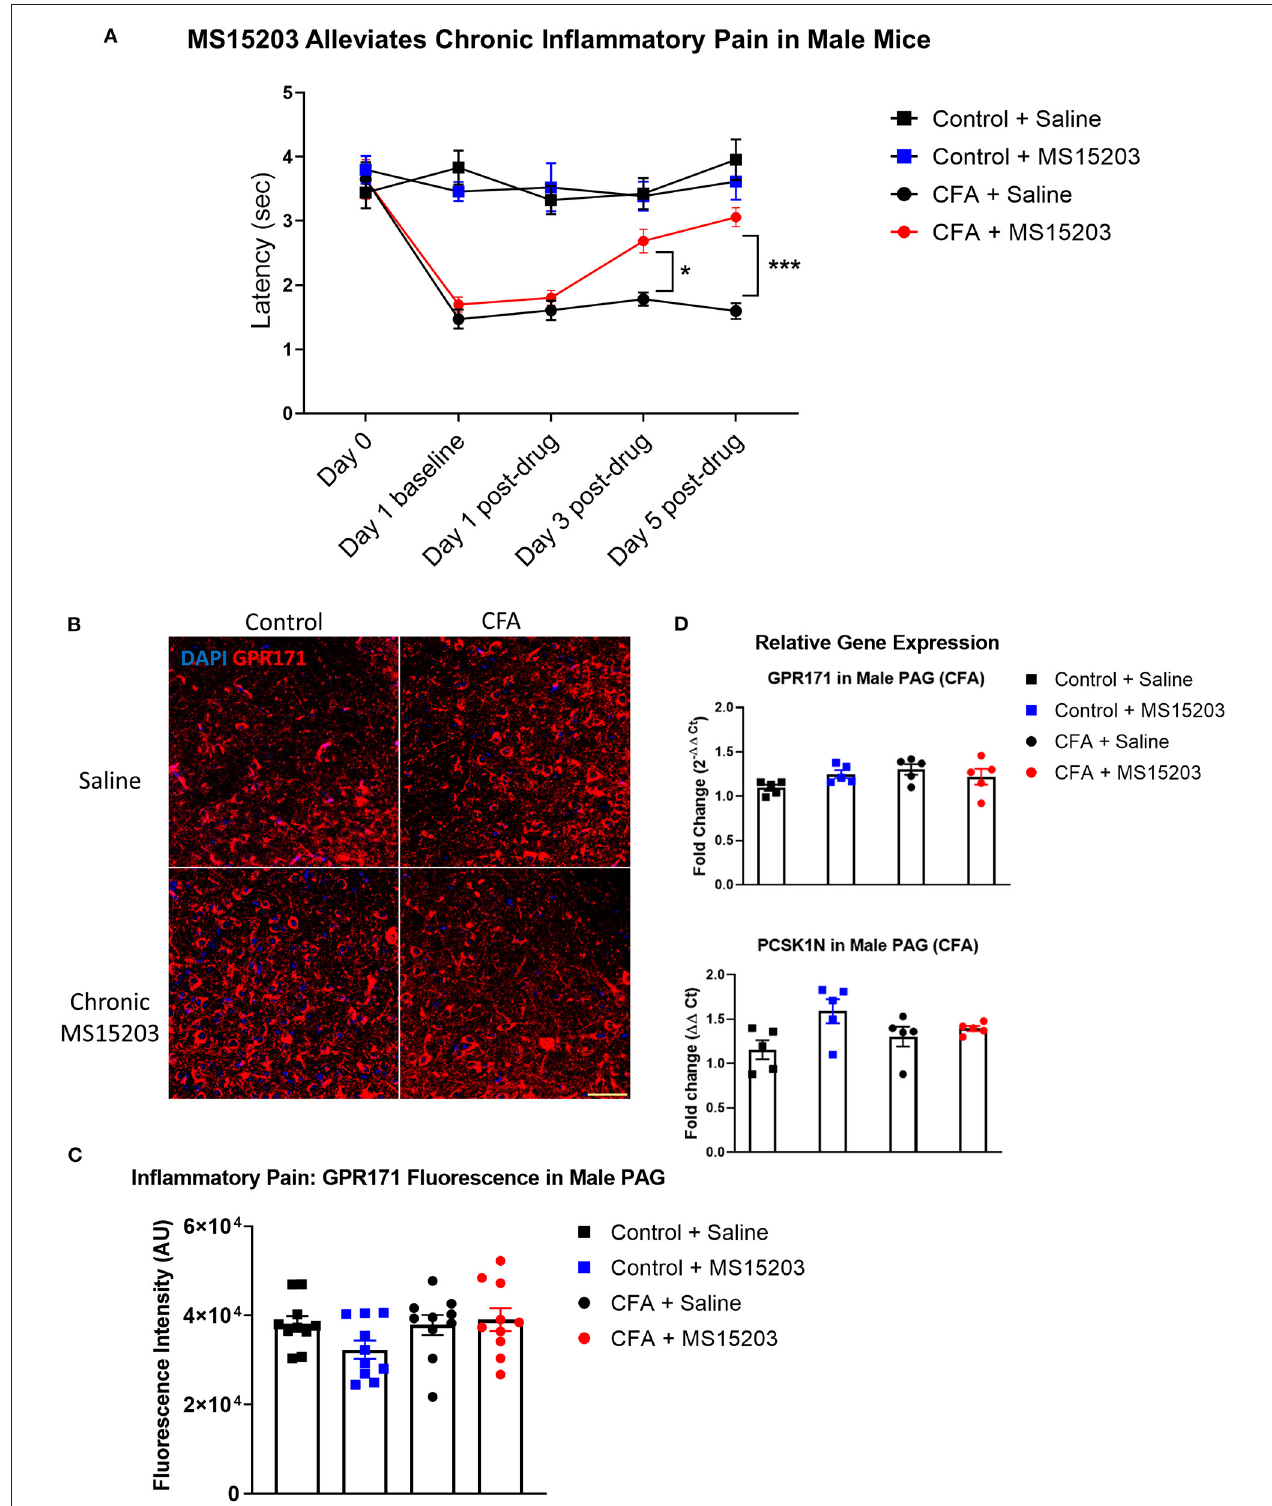
FIGURE 2 | MS15203 reduces chronic inflammatory pain in male mice. (A) Male mice ( n = 5–6/group) injected with CFA in their hind paws developed rapid thermal hypersensitivity as measured by a plantar test. Chronic treatment with MS15203 alleviated inflammatory pain by Day 3 of the treatment and the antinociception was ongoing through Day 5 as measured by an increase in thermal latencies on the plantar test. Repeated measured two-way ANOVA with Bonferroni’s post-hoc